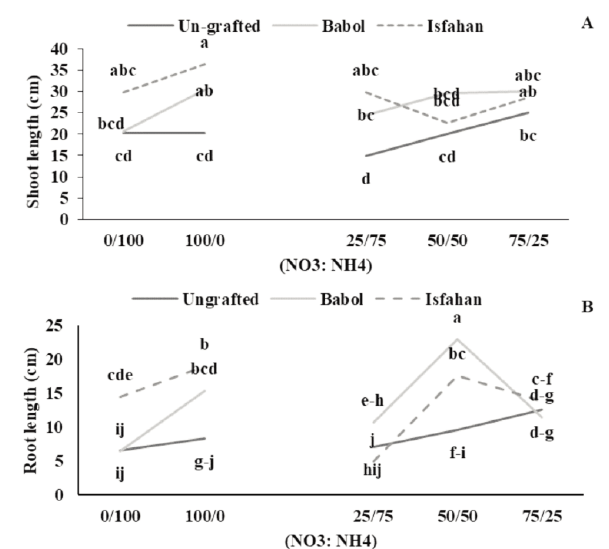
Fig. 1 ­ The interaction effect of different rootstocks and NO :NH ratio on A) shoot length and B) root length. 3 4